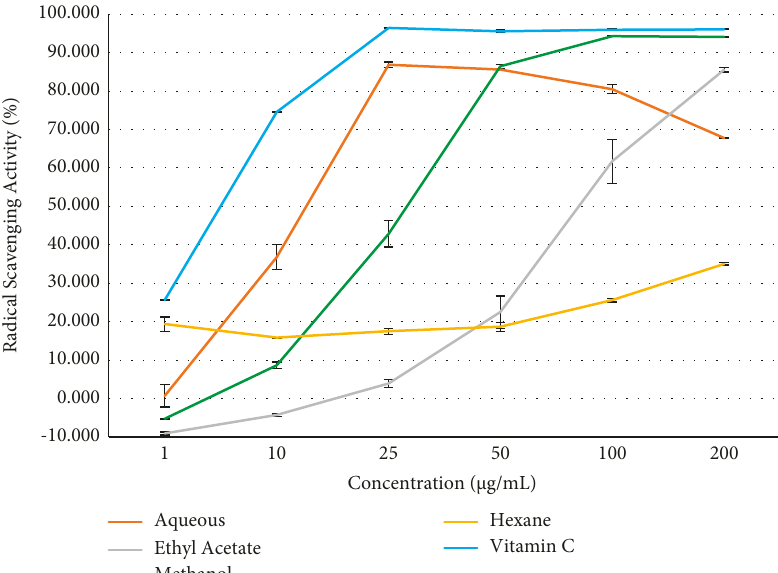
Figure 1: The free radical scavenging assay of the crude extracts when compared with the known anti-oxidant vitamin